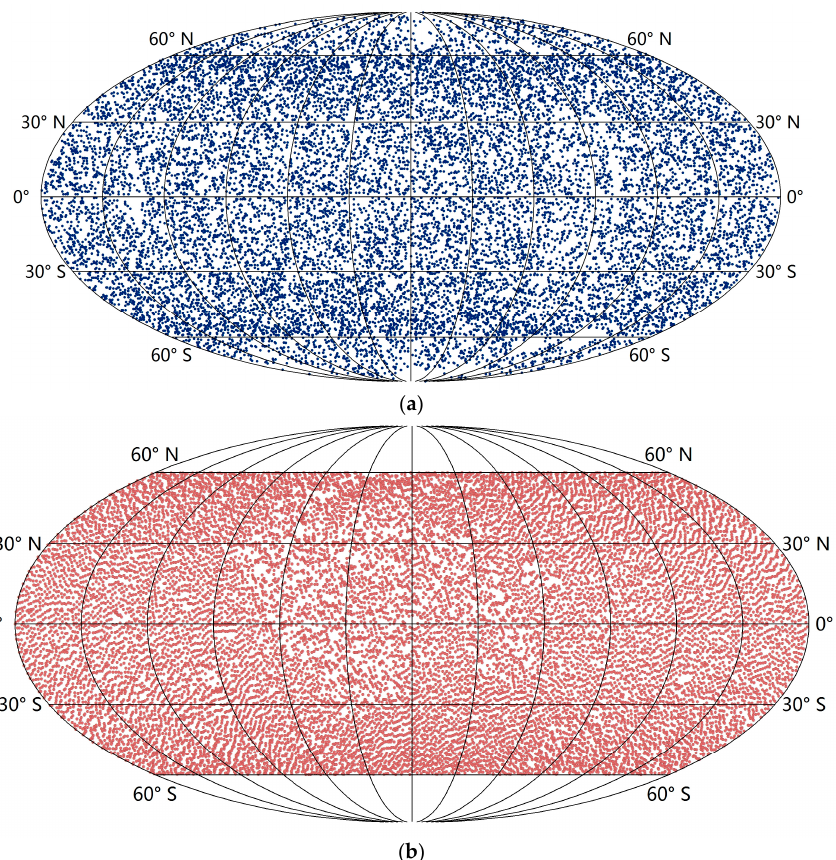
Figure 6. The distribution of the checkpoints matched from ( a ) Clementine UVVIS Warped Color Ratio Mosaic 200 m and CE1_TMap_GDOM_120m; ( b ) SLDEM2015 and CE2TMap2015_DEM_20m. The geometric displacement, i.e., the planar residual, was evaluated based on the dif- ference in planetocentric coordinates of each checkpoint pair. The planar residual was computed by the following formula: